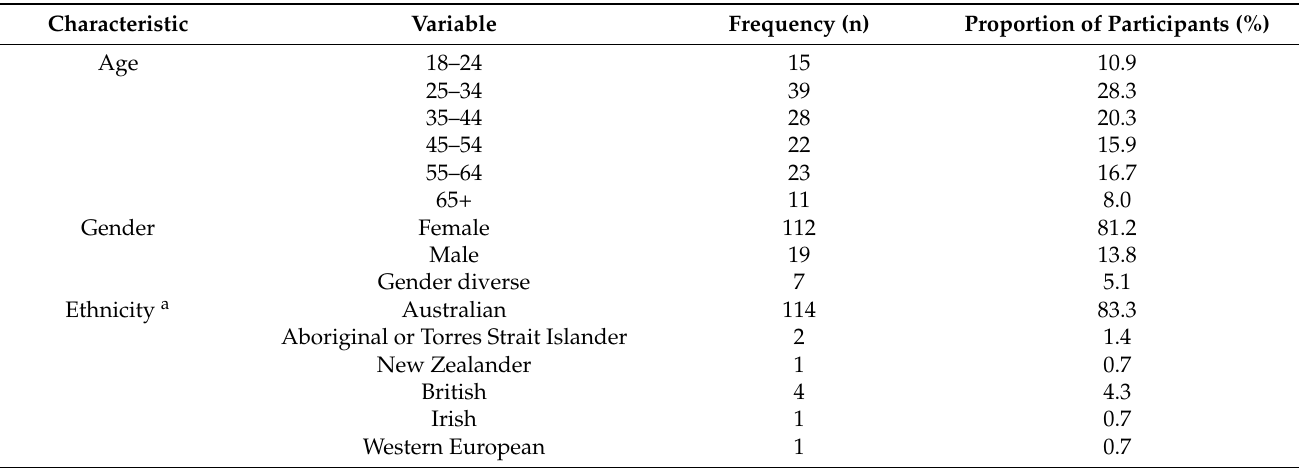
Table 1. Characteristics of participants (n =